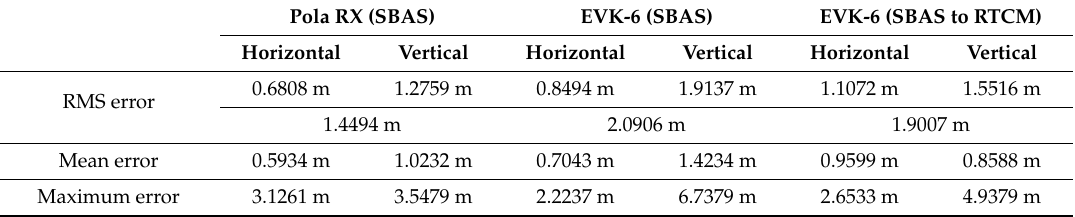
Table 2. Statistics of static test positioning